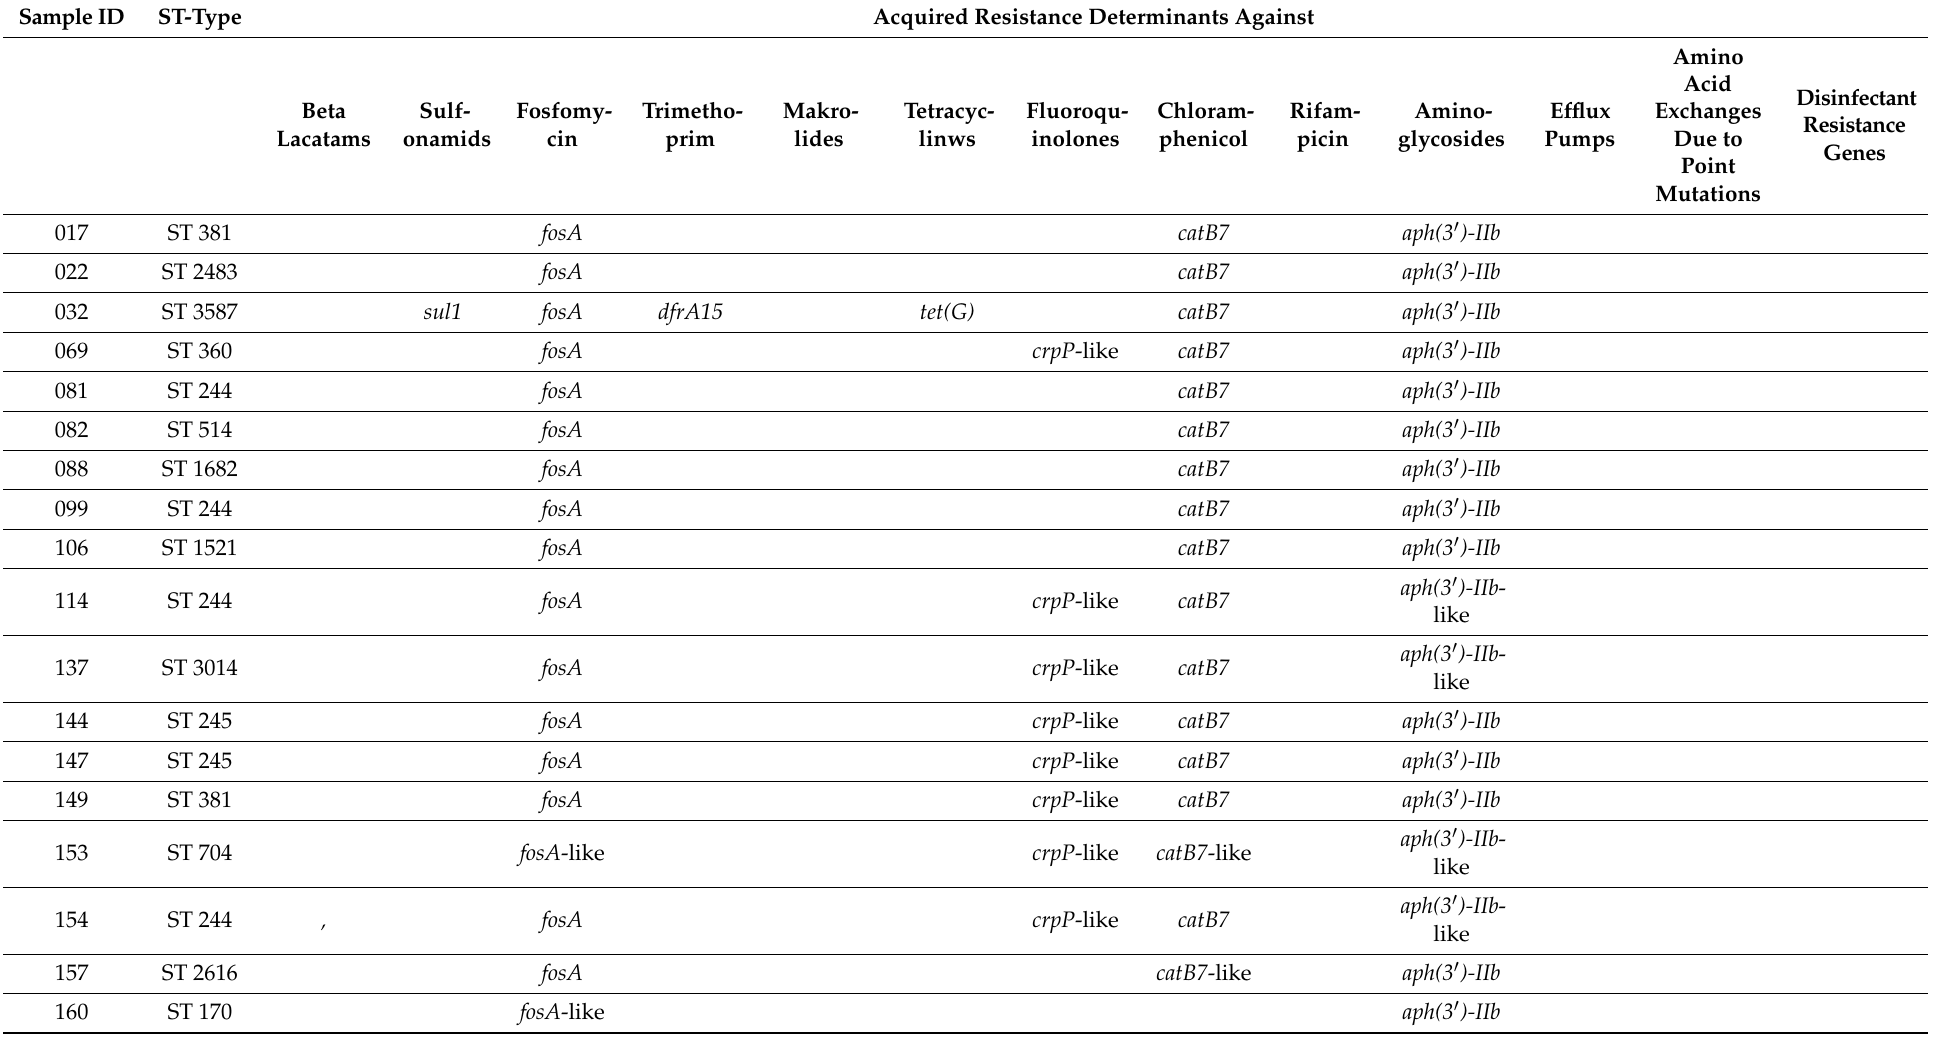
Table A1. Analysis of antimicrobial resistance determinants, ordered by strain and MLST type, of the assessed P. aeruginosa isolates. ST = Sequence type. Sample